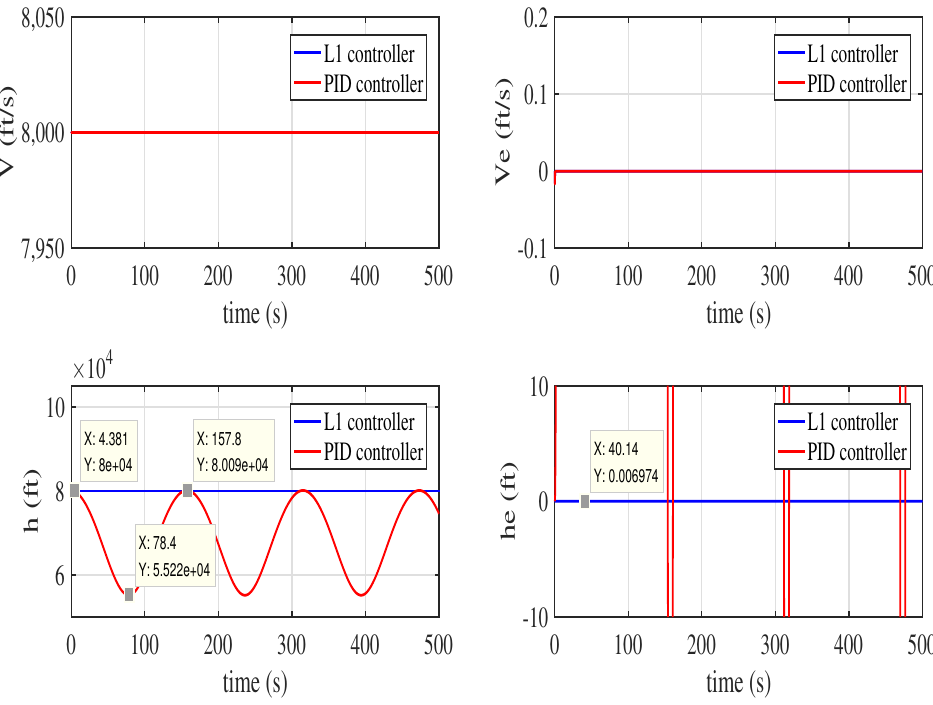
Figure 5. Comparison of velocity and velocity error, altitude and altitude error proposed by PID and L 1 controller in horizontal flight and fault state.